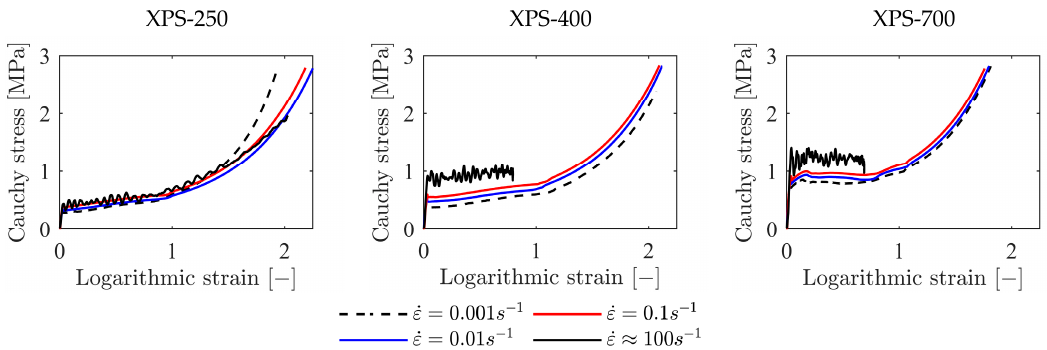
Figure 4. Stress-strain curves for the three XPS-foams at strain rates from 0.001 s − 1 to 100 s − 1